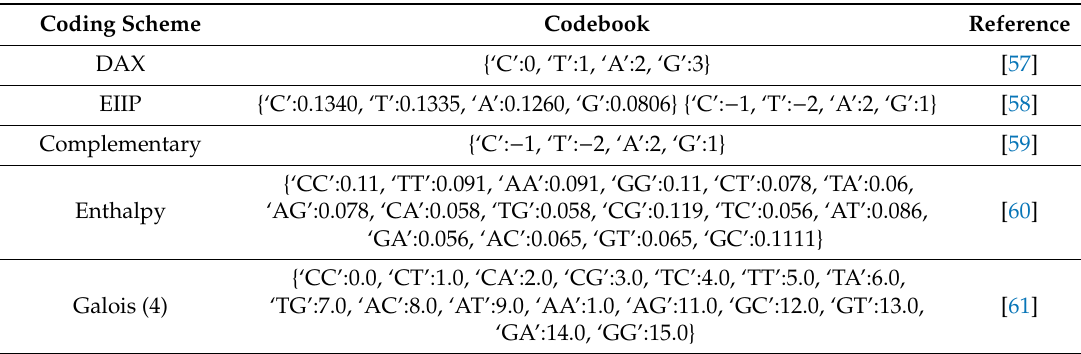
Table 2. Coding schemes for translating DNA characters in numerical representations. Adapted from